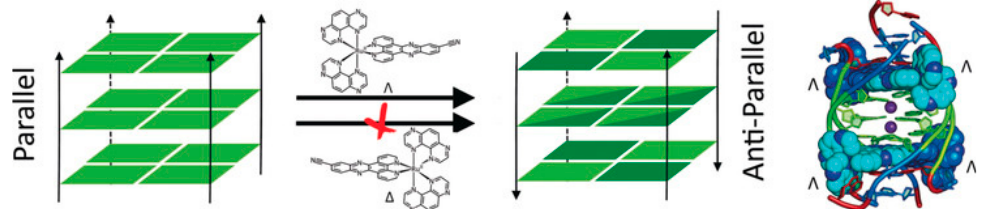
Figure 11. Drawing summarising the enantiospecific ability of a Ru–dipyridophenazine derivative to drive a parallel–antiparallel G4 ′ s transition. Reprinted with permission from Wiley—Ref [98].